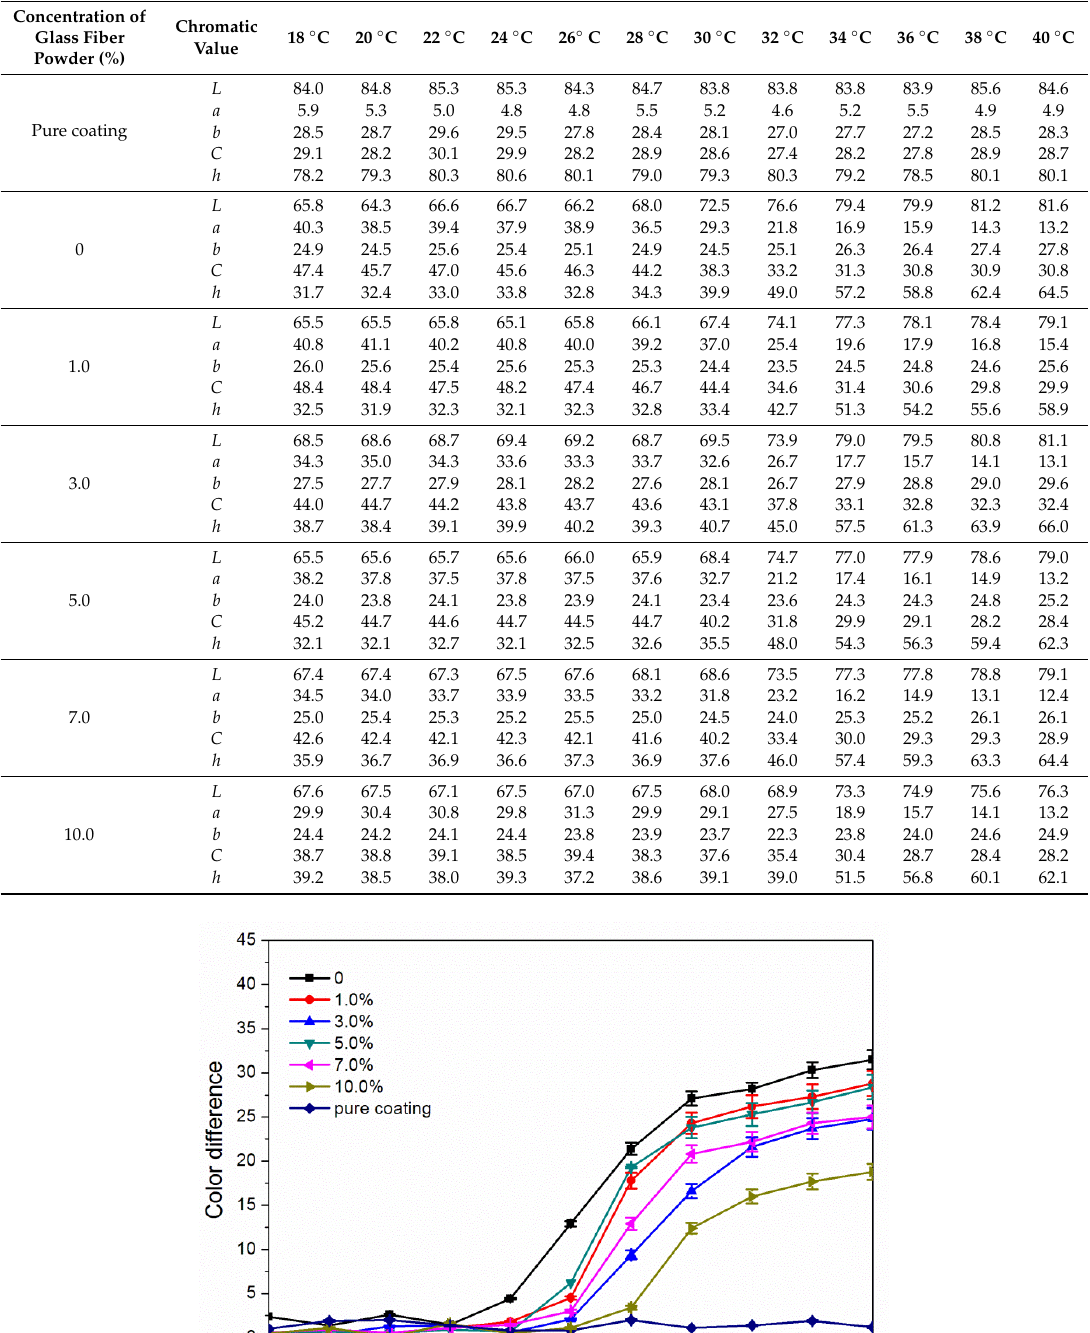
Table 2. E ff ect of glass fiber powder concentration on the chromatic value of waterborne coatings with thermochromic ink from 18 ◦ C to 40 ◦ C.